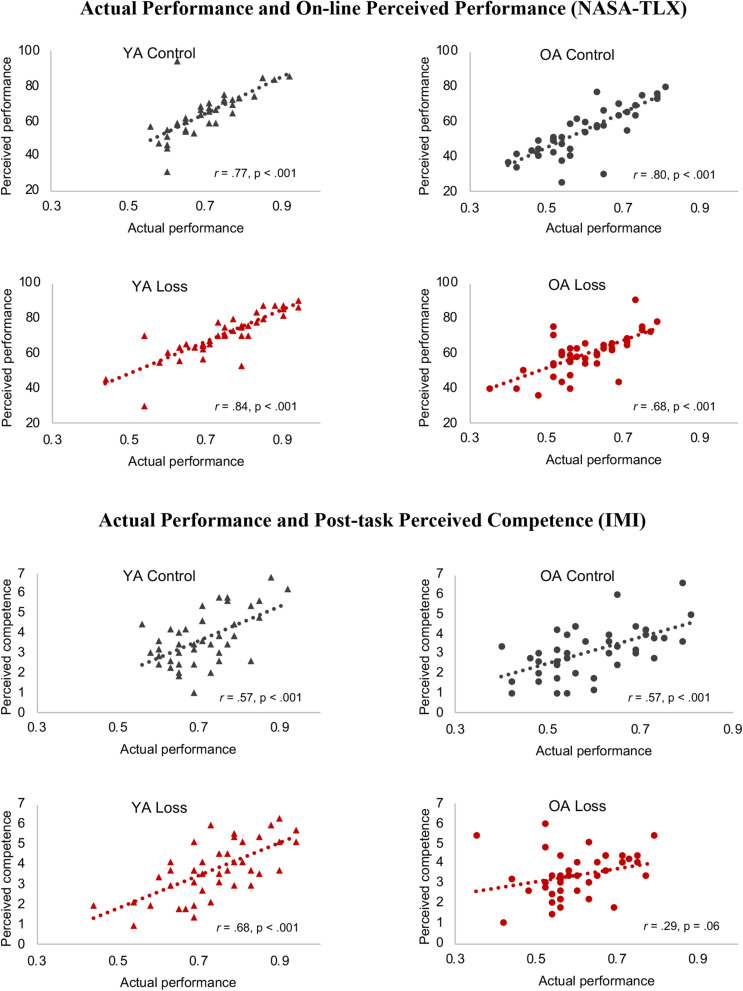
Relative metacognitive accuracy. Different colors (control = black, red = loss) and shapes [triangle = young adults (YA), circle = older adults (OA)] are used to highlight the different conditions. Correlations between actual and perceived performance were moderately strong for all four groups. A different pattern emerged for correlations between actual performance and IMI Competence ratings: this correlation was only marginal for older adults in the loss condition, while the other groups maintained moderate correlations. NASA-TLX, NASA Task Load Index; IMI, Intrinsic Motivation Inventory.